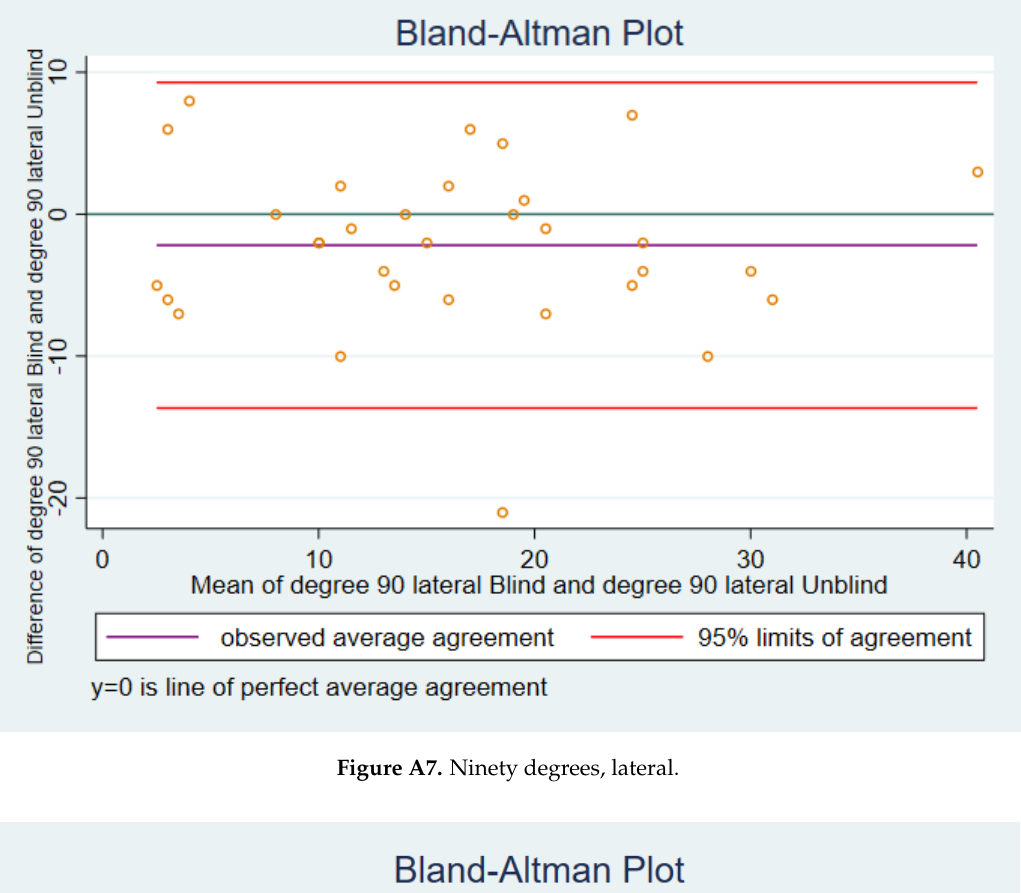
Figure A7. Ninety degrees, lateral. Appendix B.4. Ninety Degrees of Flexion Medial Soft Tissue Tension The actual mean of blinded versus unblinded differences = 0.34, and the standard deviation = 6.99. (Figure A8) The 95% limits of agreement were − 13.35 to 14.04.